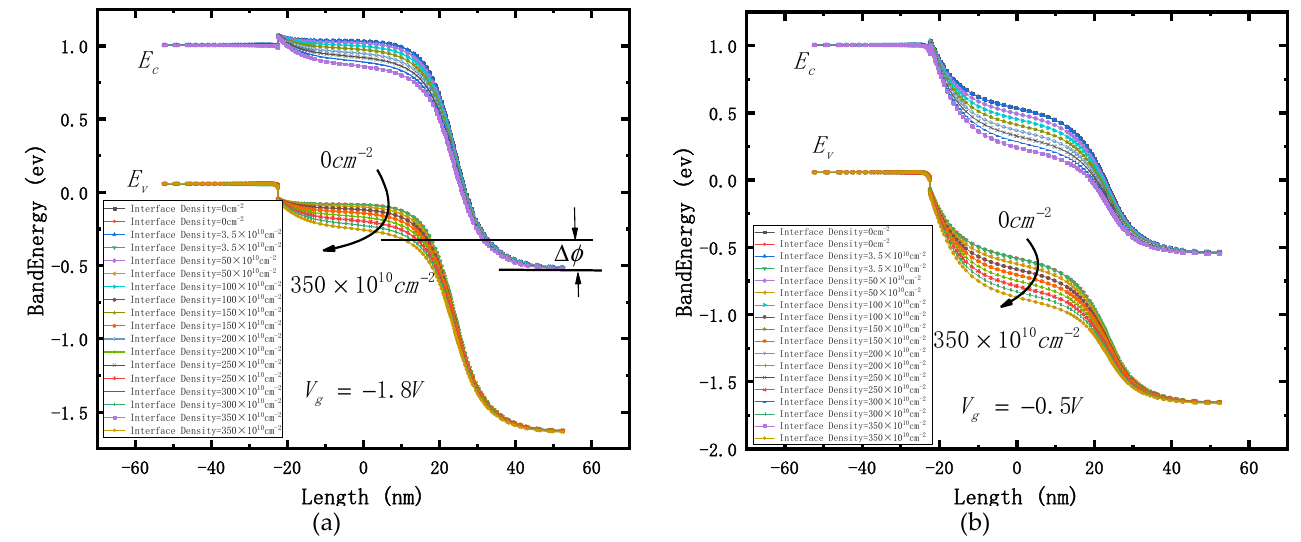
Figure 9. Band diagram with different interface density. ( a ) Gate voltage = − 1.8 V; ( b ) gate voltage = − 0.5 V.